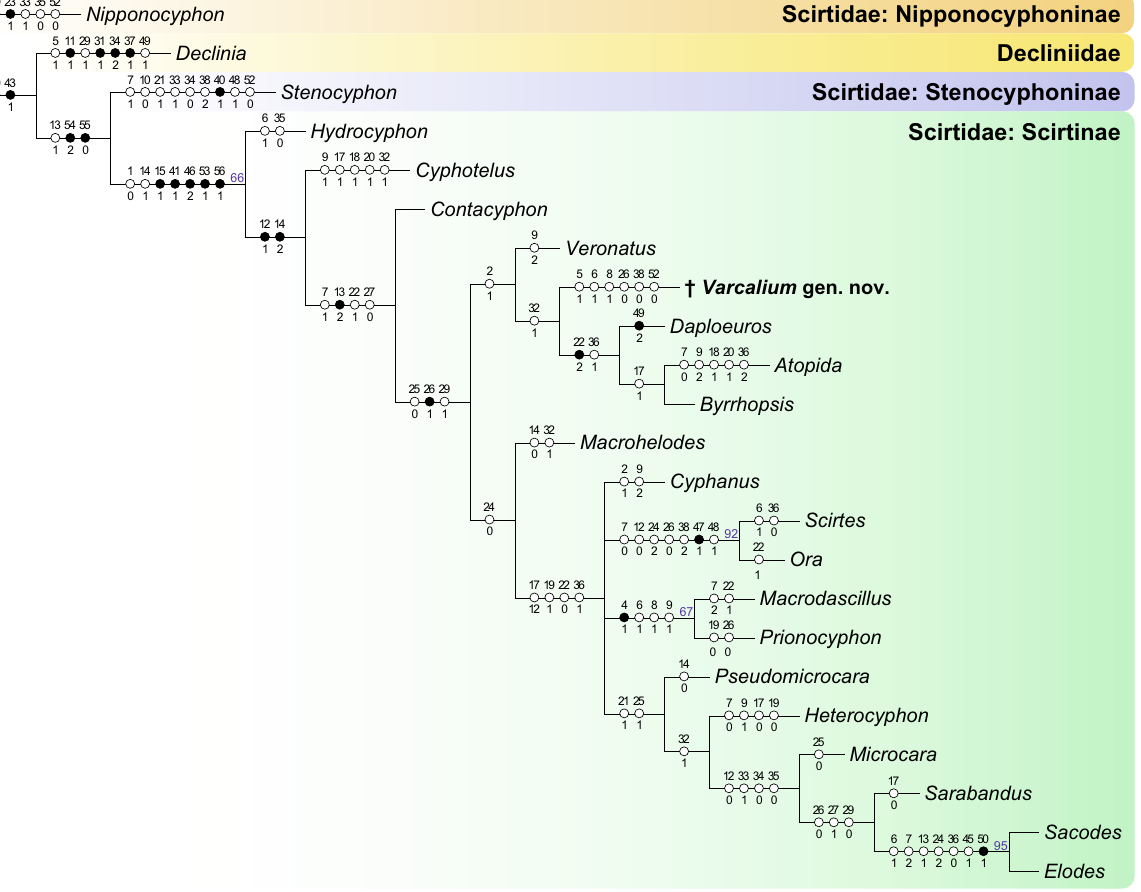
Figure 5. Placement of Varcalium gen. nov. within Scirtidae. Black circles indicate nonhomoplasious changes; white circles indicate homoplasious characters. Bootstrap support values lower than 60% are not